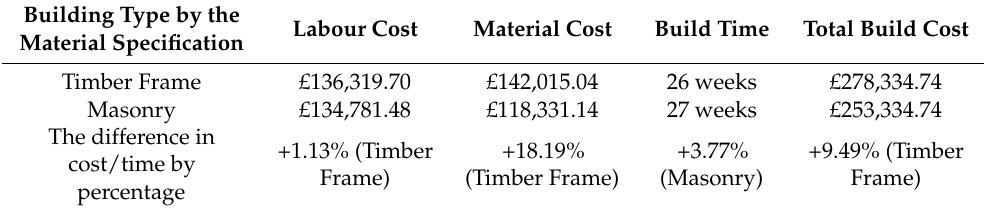
Table 1. Build cost and time comparison between timber frame and masonry.